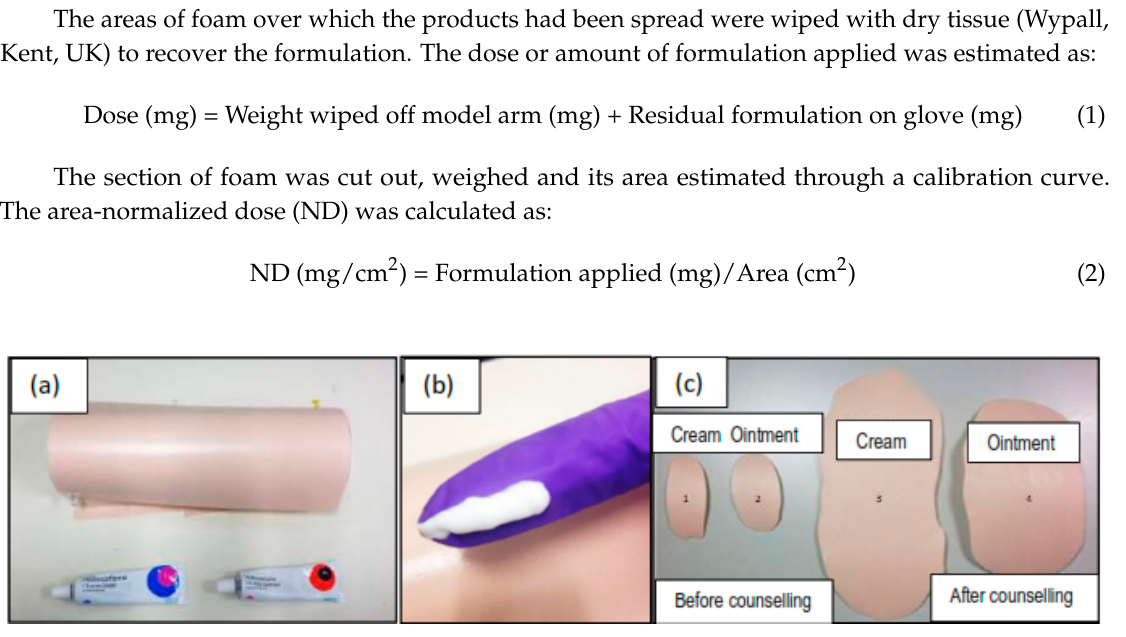
Figure 1. ( a ) model arm and formulations; ( b ) example of fingertip of formulation measured by one participant ( c ) representative set of areas used by one participant. From left to right: cream before